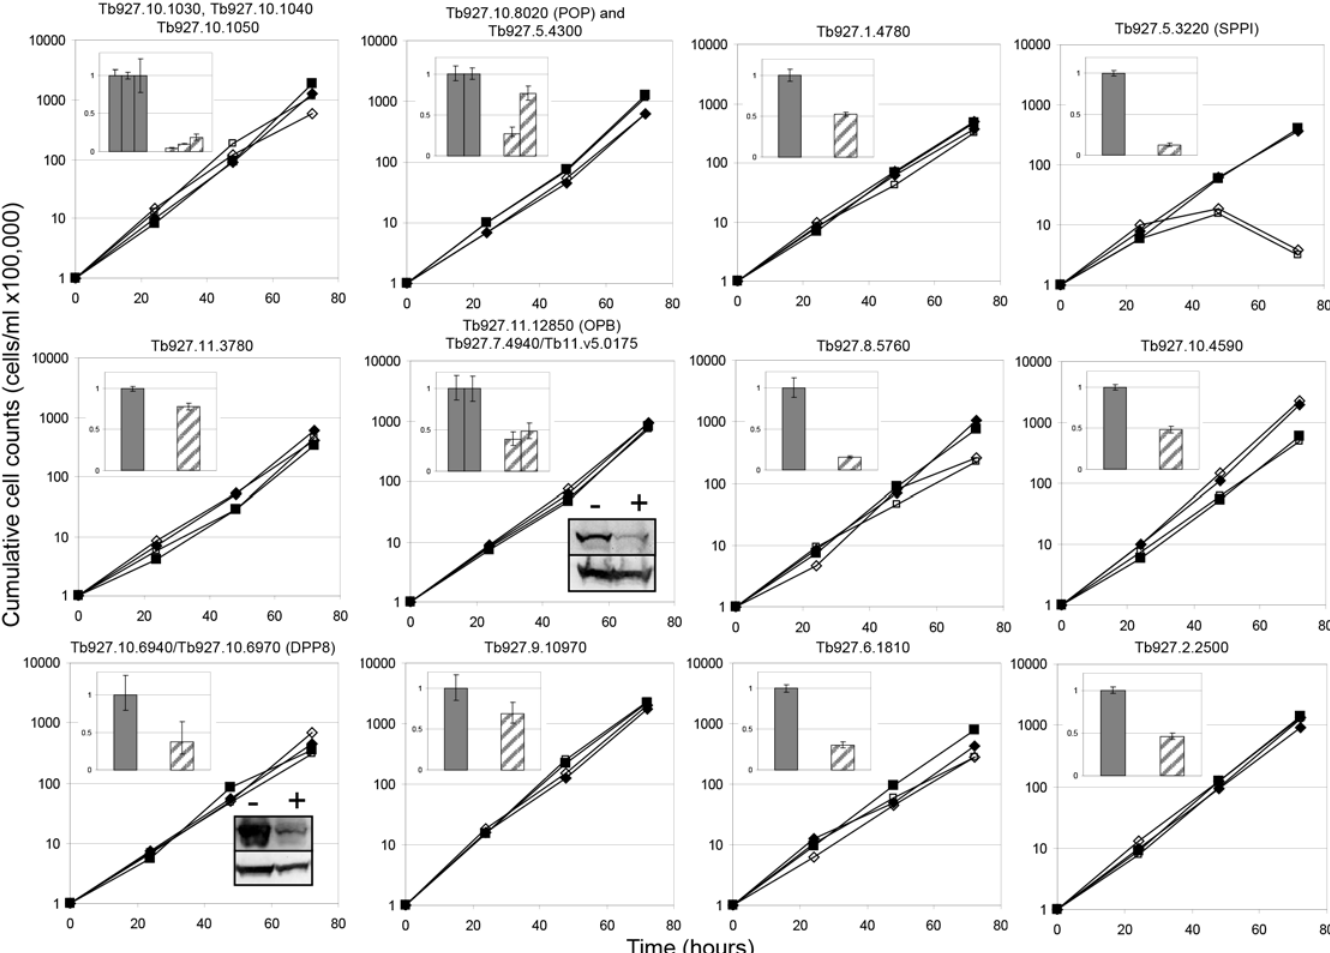
Fig 1. Effect of RNAi of serine peptidases on T . brucei cell growth in vitro . Two independent RNAi cell lines were induced with 1 μ gml -1 tetracycline (open symbols) or left untreated (filled symbols). Cells were counted every 24 hours, diluted down to 1 x 10 5 cells ml -1 and the cumulative cell number calculated. Insets: Target transcript levels in RNAi cell lines. Insets (upper left): Total RNA was isolated from non-induced (solid bars) or tetracycline-induced (striped bars) cells and used to make cDNA, which was used as a template in a real time PCR reaction using gene-specific primers (S2 Table). For cell lines in which multiple genes with non-identical sequences were targeted, PCR results for each target are shown. Results from three technical replicates are shown. Insets (lower right): For two targets, Western blots were done on lysates from control (-) or tetracycline induced (+) cells, using RNAi target protein- specific antibody (upper panel) or α -EF1- α (lower